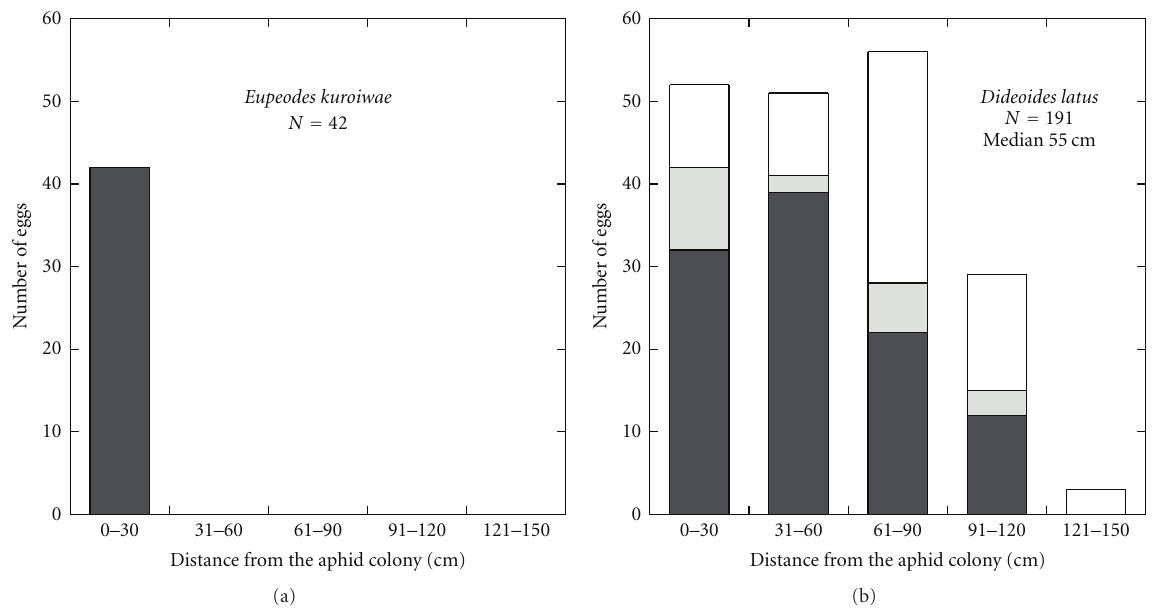
Figure 14: Distribution of eggs laid by two syrphid species in and around a colony of the aphid Ceratovacuna lanigera formed on the grass Miscanthus sinensis . Eggs that were and were not attacked by aphid nymphs within first three days are indicated by dark grey and white areas, respectively, and those that disappeared within first three days by light grey areas. (a) Eupeodes kuroiwae . Although all laid eggs were attacked, the hatchability of attacked eggs in E. kuroiwae (71.9%) was much higher than that in Dideoides latus (29.8%) (2 × 2 Fisher’s exact test; P (cid:4) . 0001). (b) Dideoides latus . Eggs of D. latus that were laid more than 55 cm (the median) away from the colony were less likely to be attacked by aphid nymphs than those that were less than 55 cm away (2 × 2 Fisher’s exact test; P = . 0001). Also, the hatchability of attacked eggs (29.8%) was lower than that of unattacked eggs (70.1%) (2 × 2 Fisher’s exact test; P (cid:4) . 0001) (redrawn and recalculated from data in